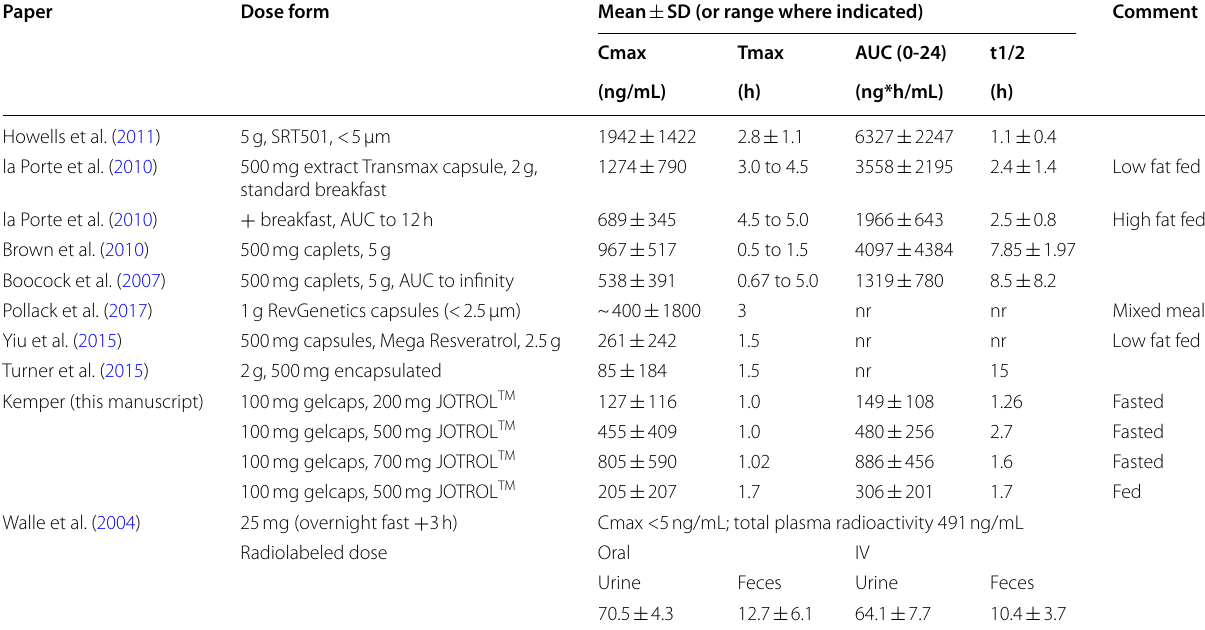
Table 8 A summary of published clinical pharmacokinetics compared to the PK derived from the data with this study